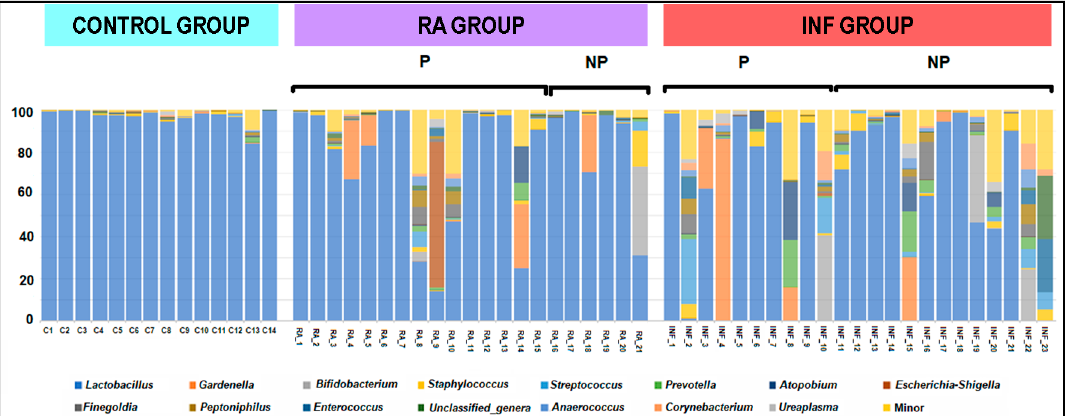
Figure 5. Relative abundance of the predominant bacterial genera in CVL samples of healthy fertile women (C), women with repetitive abortion (RA) and women with infertility of unknown origin (INF). In women with a history of reproductive failure, because either of recurrent miscarriage (RA group) or infertility (INF groups), P indicates the group of women who got pregnant after the probiotic intervention with L. salivarius CECT5713 and NP those women who did not.